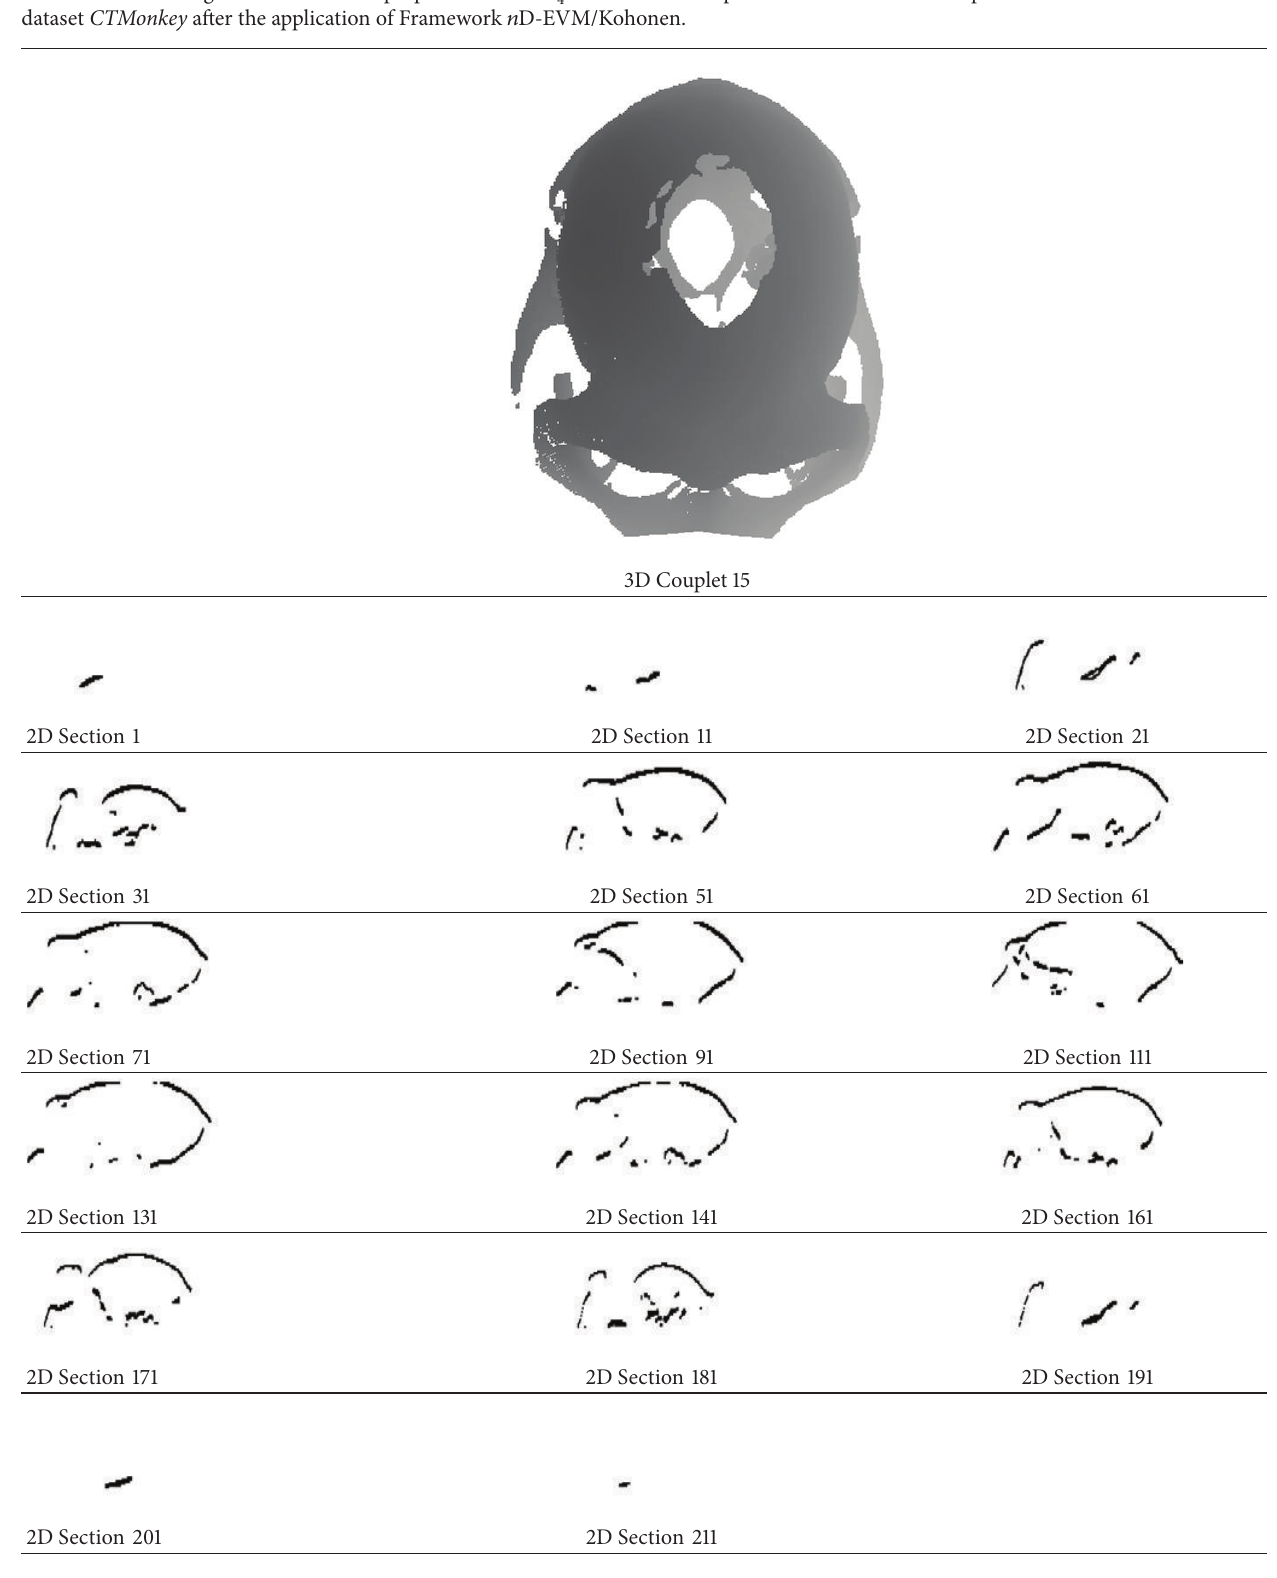
Table 16: Visualizing some 2D sections perpendicular to 𝑋 4 -axis which were processed from one 3D couplet of the 4D-OPP associated to dataset CTMonkey after the application of Framework 𝑛